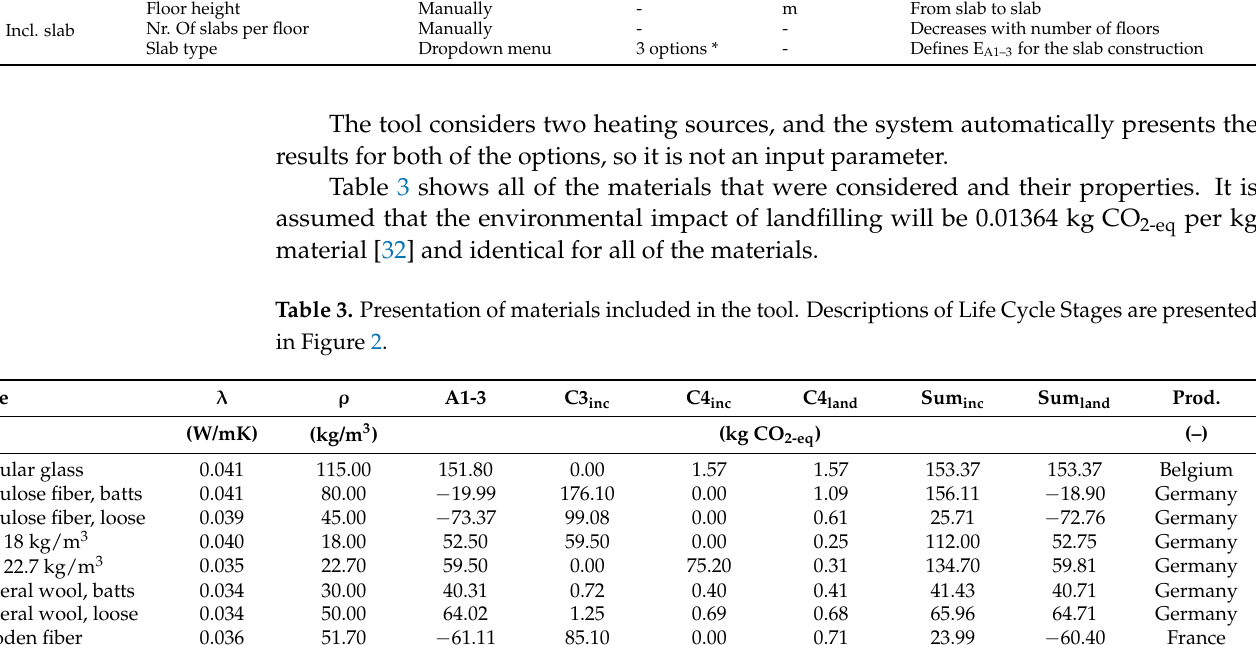
Table 4. Definition of the specific wall applied to Scen wall cases.